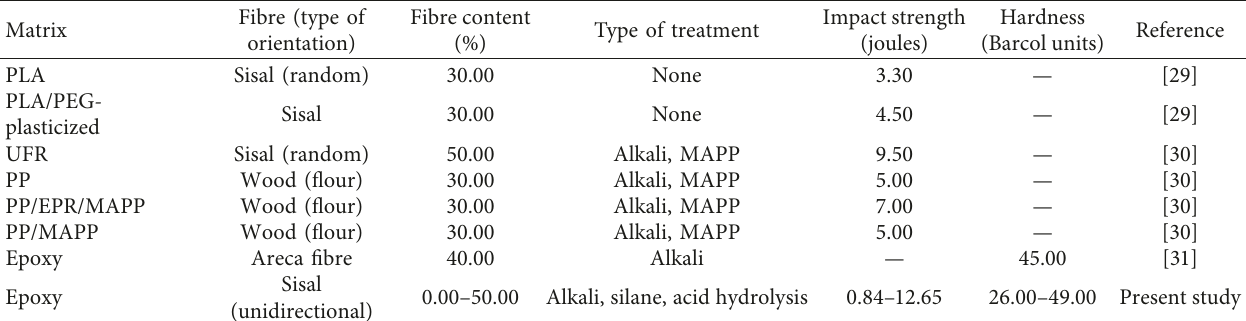
Figure 7: A plot of average values of the Barcol hardness (BU) versus fibre weight fraction % for treated and untreated sisal fibre-epoxy resin composites. Table 3: A summary of impact strength and hardness of selected natural fibre